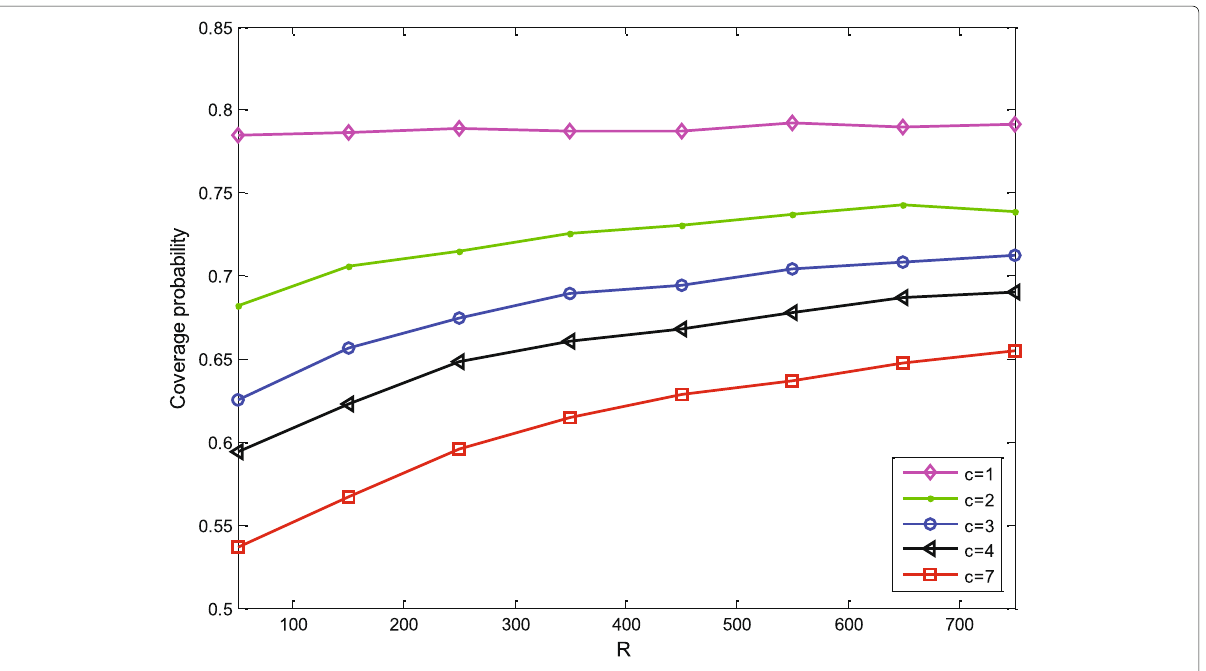
Fig. 10 Coverage probability vs. the cluster radius